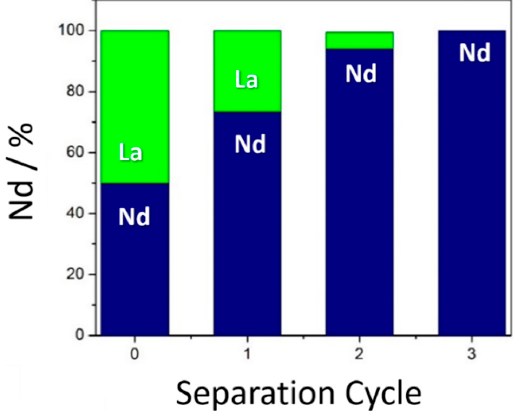
Figure 21. Fractionation of La 3+ and Nd 3+ mixtures, starting from an equimolar solution (stage 0) and subsequent MNHM processing by using superparamagnetic nanoparticles functionalized with DTPA, as described in the text (adapted with permission from [29]).